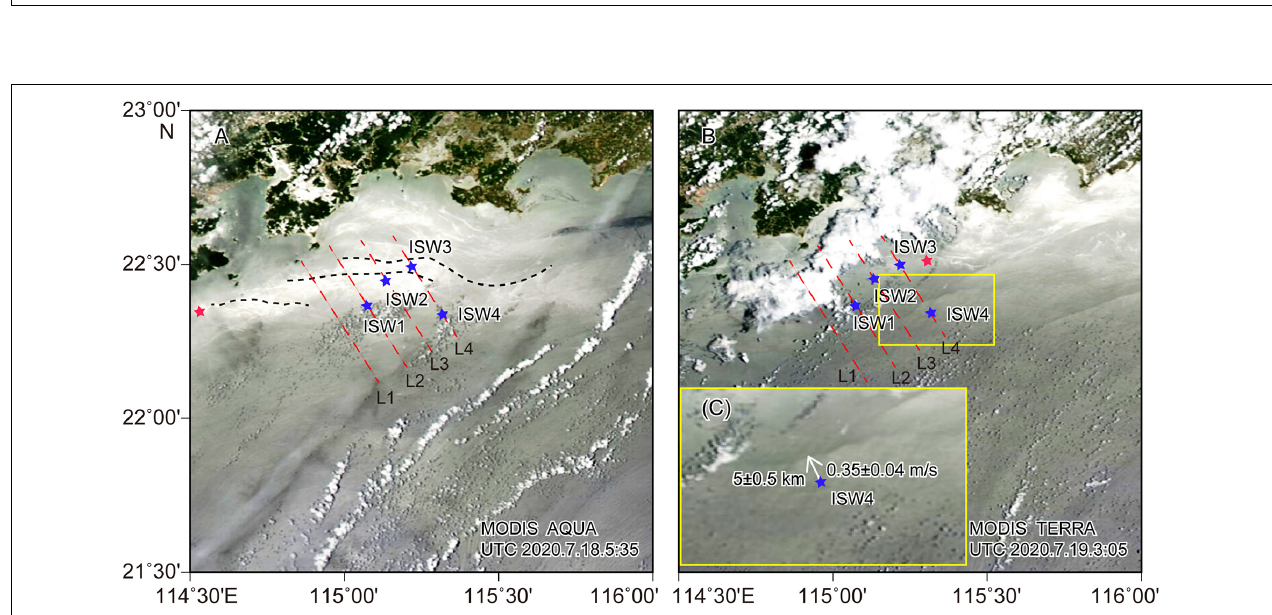
Frontiers in Marine Science |